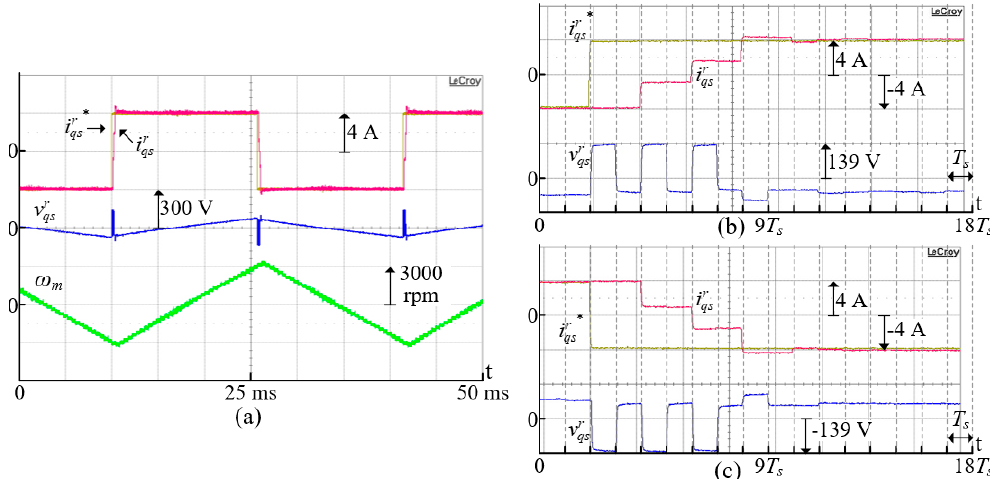
Figure 19. q -axis current, voltage, and speed when the motor cycles between − 3000 rpm and 3000 rpm with step current command, ( a ) complete waveform, ( b ) amplified view when current command steps from − 4 A to 4 A, ( c ) amplified view when current command steps from 4 A to − 4 A.